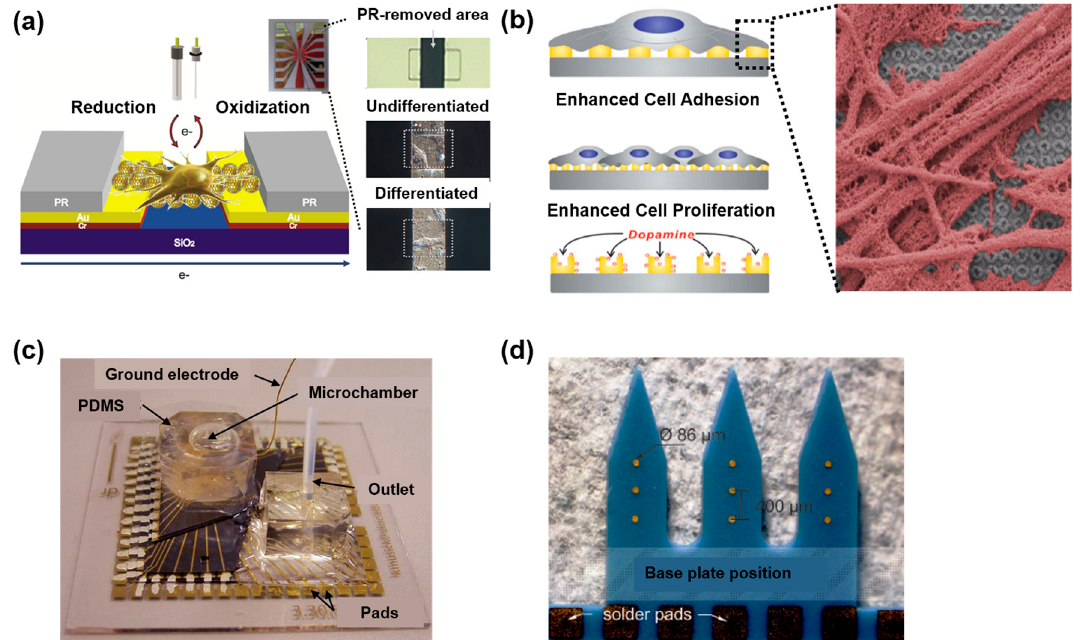
Figure 6. Electrochemical system for the analysis of various nervous signals on the micro-platform. ( a ) Schematic diagram of the electrochemical characteristics of undifferentiated/differentiated single mouse NSC (mNSC). The redox characteristics of single mNSC in two different states can be verified by using this micro gap substrate. Reproduced with permission [100]. Copyright 2013, Elsevier; ( b ) The NSC-based chip consists of large-scale homogeneous nano-cup electrode arrays (LHONA) used for the detection of dopamine released from dopaminergic cells. Reproduced with permission [114]. Copyright 2015, Wiley; ( c ) Multielectrode arrays (MEA) platform for long-term noninvasive assessment of human dorsal root ganglia (DRG) cell health and function. The inset shows the bright field micrograph of electroplated MEA. Reproduced with permission [115]. Copyright 2009, Royal Society of Chemistry; ( d ) The low-temperature cofired ceramics (LTCC) model for the design of a 3D-MEA. Finger conductor circuit with tower electrodes is designed to fit measurement adapters for signal recordings and data processing. Reproduced with permission [122]. Copyright 2015, Göller Verlag GmbH.